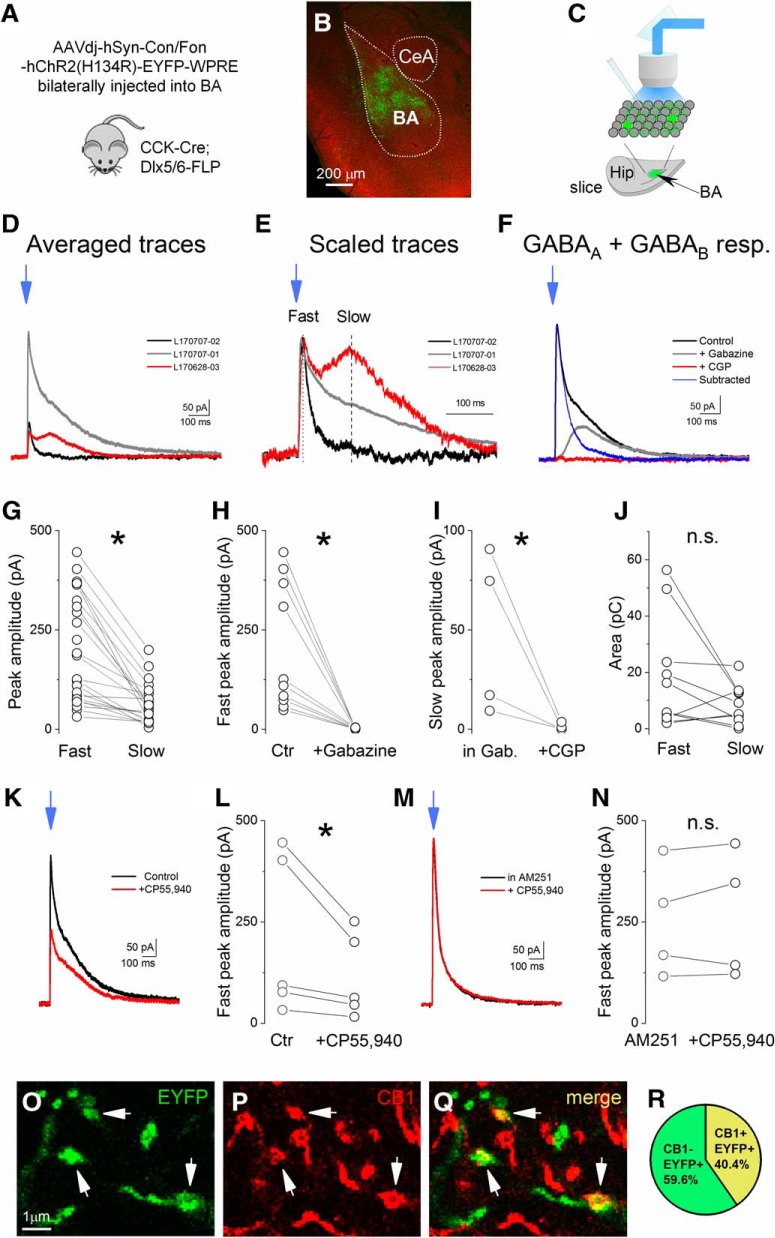
Photostimulation of GABAergic cells in the BA. A, Schematic drawing showing the intersectional viral strategy used to target CCK+ INs in CCK-Cre;Dlx5/6-FLP double-transgenic mice. B, Example of INTRSECT AAVdj-hSyn-Con/Fon-hChR2(H134R)-EYFP-WPRE (INTRSECT-ChR2) expression in the BA (CeA = central amygdala). C, Schematic drawing represents a horizontal slice with viral expression shown in green (Hip = hippocampus). Whole-cell patch clamp recordings were performed in non-green cells, likely in PNs in slices prepared from double-transgenic mice injected with AAV containing INTRSECT-ChR2. D, E, Averaged traces of five consecutive PSCs obtained in three different neurons evoked by light illumination (blue arrow). High variability both in peak amplitude (D) and decaying phase (D, E) is typical for events evoked in different neurons. The traces in E are peak scaled. Dashed lines show where the peak amplitude for fast and slow components of evoked currents was measured. F, Traces from an experiment measuring the antagonist-sensitivity of light-evoked responses. Gabazine (5 µM) wash-in eliminated the fast GABAA-mediated component, while CGP 5699A (1 µM) blocked the remaining slow GABAB-mediated component. Importantly, no inward, i.e., EPSC, could be observed in the presence of the GABA receptor antagonists, indicating that the applied intersectional strategy allowed us to excite selective GABAergic cells. G, Peak amplitude of the fast components in evoked responses measured in the same neurons was significantly larger than the peak amplitude of the slow components. H, The fast components were blocked by bath application of gabazine (*paired t test). I, The slow components were eliminated by CGP 5699A wash-in. J, The area, i.e., the charge of the fast and slow components evoked in the same neurons, was not different. GABAA receptor-mediated fast responses were isolated by subtracting the responses recorded in the presence of gabazine from the control traces and their area was measured. Example traces (subtracted) are shown in F. The area of the GABAB receptor-mediated slow components were determined on the traces recorded in the presence of gabazine. K, Averaged traces taken from an example experiment indicate that the light-evoked PSCs are smaller on wash-in of a CB1R agonist, CP 55,940 (2 µM). L, In all experiments tested, bath application of CP 55,940 significantly reduced the peak amplitude of the fast component. M, Averaged traces taken from an experiment showing that, in the presence of the CB1R antagonist, AM251 (2 µM), bath application of CP 55,940 (2 µM) did not cause a reduction in the peak amplitude. N, Preincubation of the slices in AM251 prevented the CP 55,940-induced reduction of the peak amplitude of light-evoked postsynaptic responses. O–Q, A portion of EYFP-expressing axon terminals is immunoreactive for CB1 (arrows). R, Approximately 40% of EYFP-expressing axonal varicosities were immunopositive for CB1R (156 EYFP+ varicosities were tested in two mice); *p < 0.05 fast versus slow, +gabazine versus control (Ctr), +CGP versus in gabazine (Gab), +CP versus Ctr. n.s., non-significant.